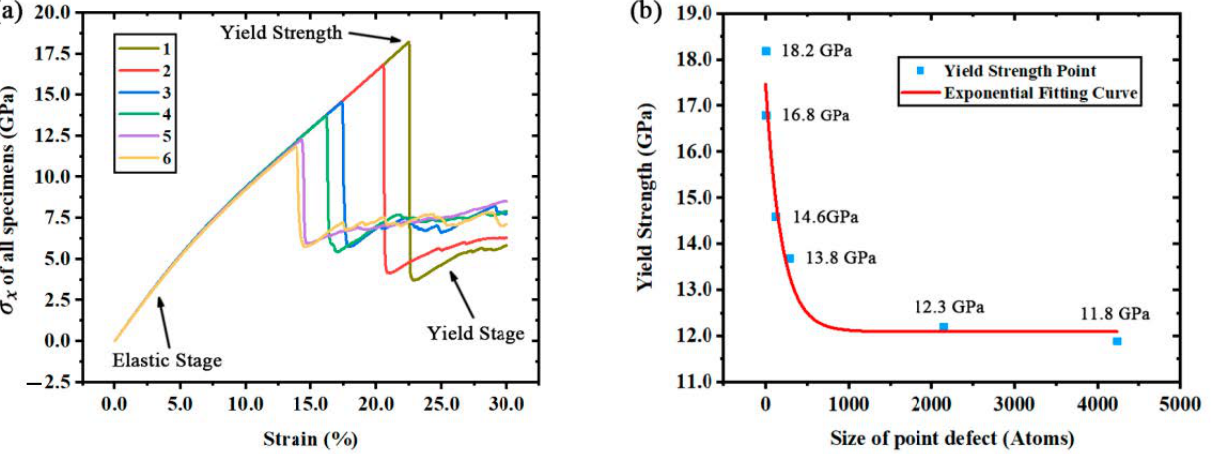
Figure 2. ( a ) Stress-strain curves of all specimens. ( b ) Exponential fitting curve of yield strength and defect size. As shown in Figure 2b, while doing some statistical work about the effects of point defects on mechanical properties, it is found that the size of point defects and the yield strength σ s follow an exponential